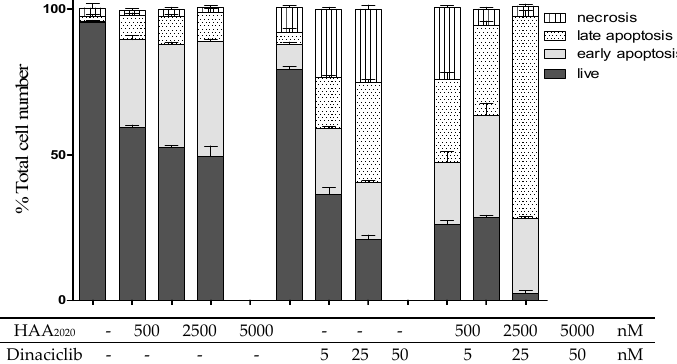
Figure 6. Detection of apoptosis in MCF7 cells (Total number %, 24 h). Cells were treated with either